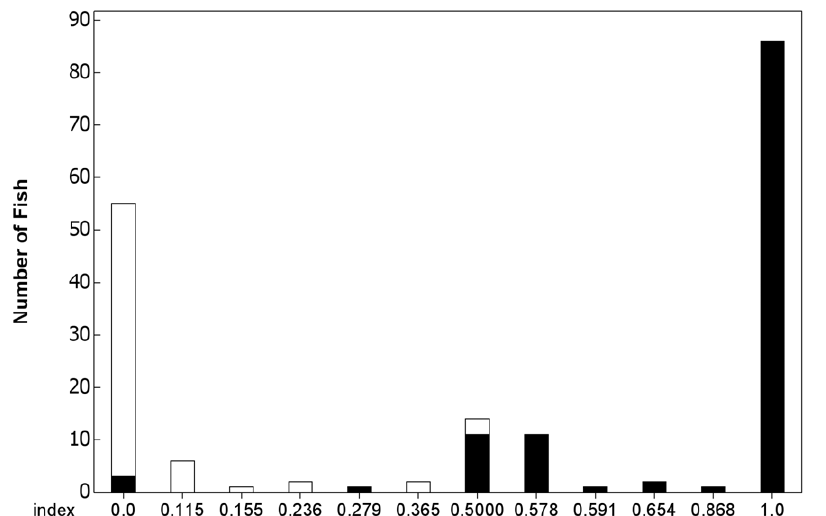
Figure 1. Hybrid Index Histogram. Numbers of phenotypic cutthroat (white bars) and phenotypic steelhead (black bars) classified along a continuum of hydrid indices ranging from 0.0 (pure cutthroat) to 1.0 (pure steelhead).